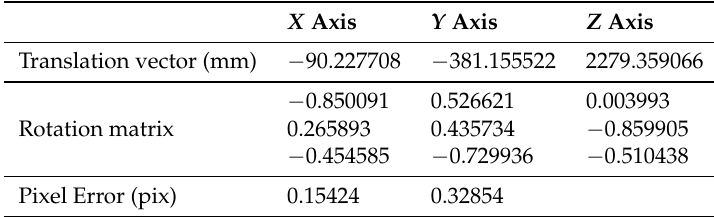
Table 4. Extrinsic parameters of the left